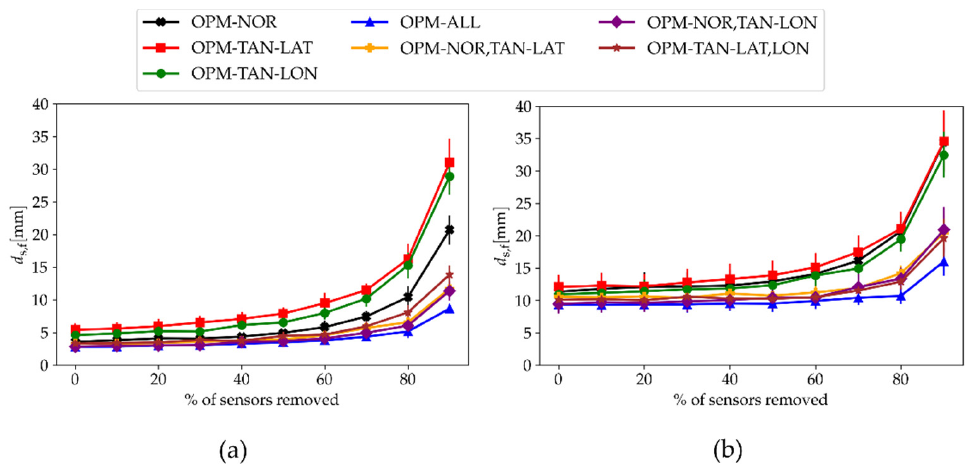
Figure 8. Distance between simulated and fitted dipoles ( 𝑑 s,f ) averaged over all 100 time samples and eight subjects in relation to the number of sensors for seven different OPM-MEG configurations. The strength of the ambient noise and the spontaneous brain noise was ( a ) 𝜎 = 75fT and 𝑞 spont = 0, and ( b ) 𝜎 = 0 and 𝑞 = 3nAm .